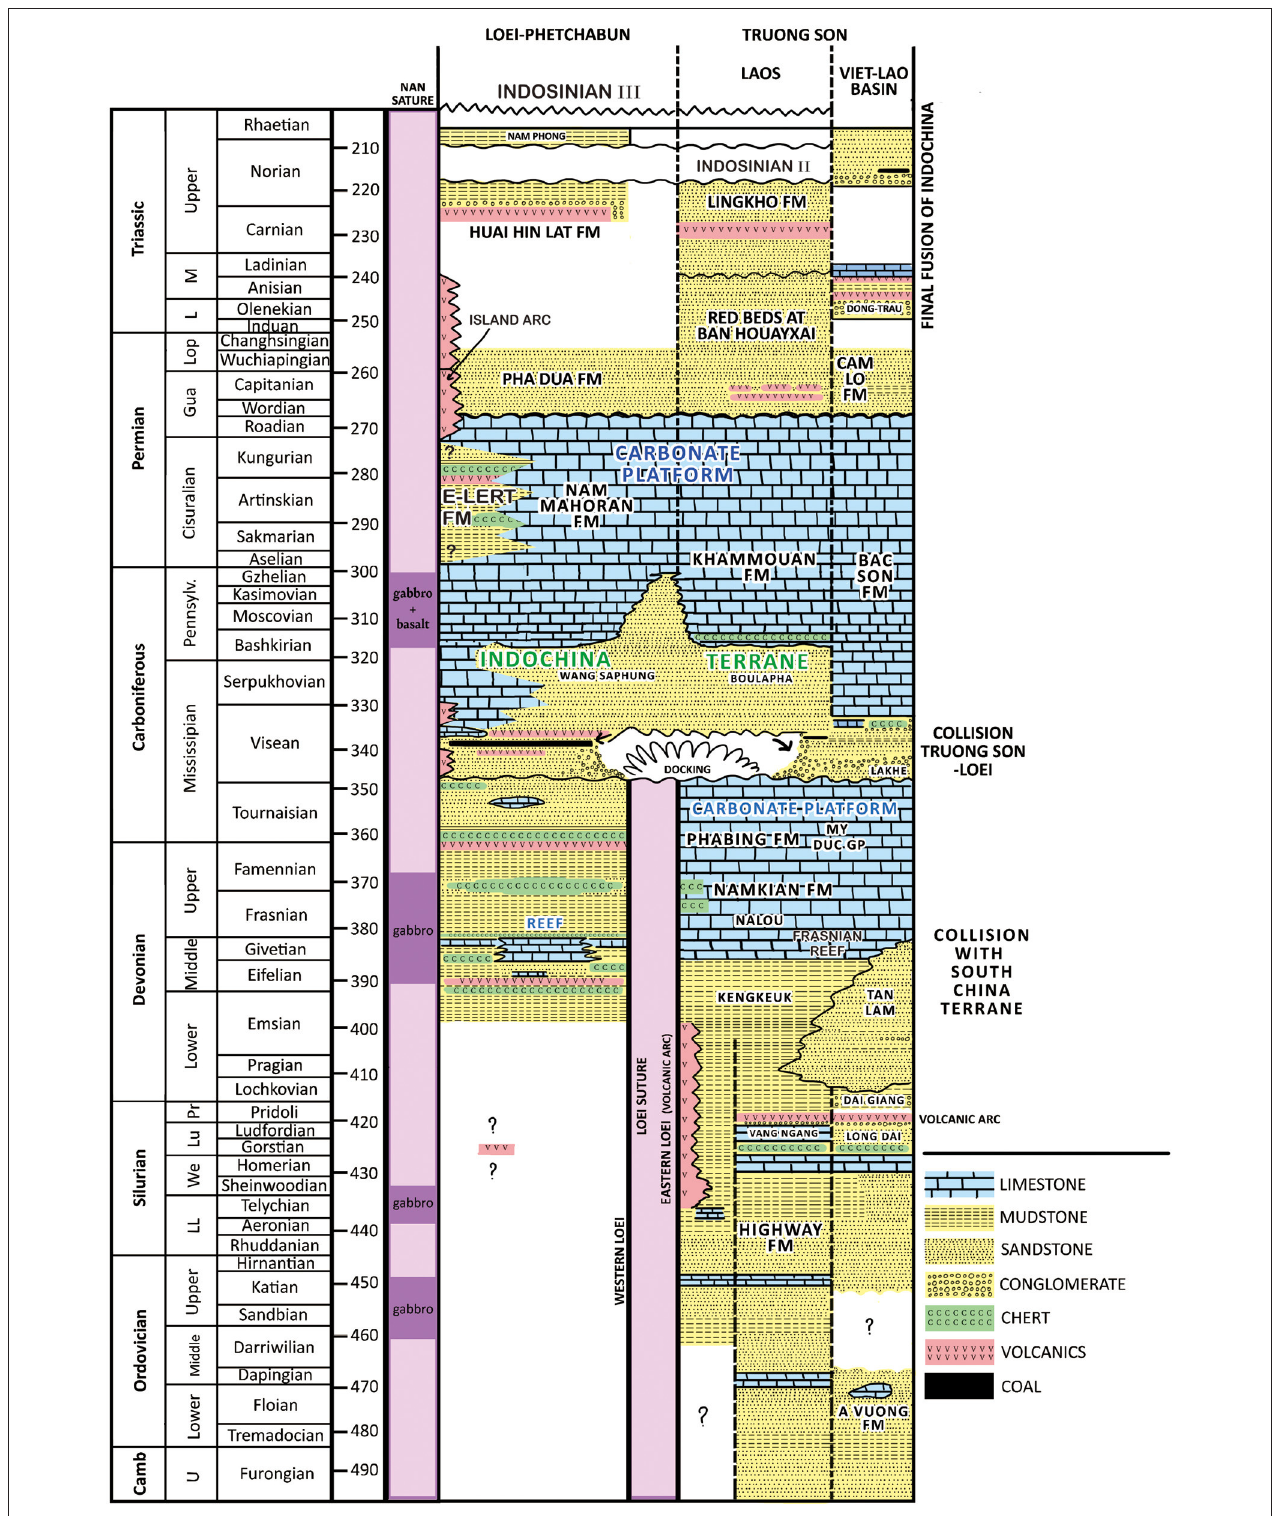
FIGURE 2 | Summary diagram of present hypothesis showing summaries of stratigraphies, deformation episodes, and magmatic events in the Loei-Phetchabun and Truong Son terranes. Stratigraphic data are from numerous sources. Ordovician gabbro within the Nan Suture is from Khin et al. (2014) and Long et al. (2019) and Devonian and Carboniferous dates are from Shen et al. (2010a). The Tan Lam Formation in the Vietnamese sector of Truong Son represents the influx of coarse terrigenous siliciclastics caused by the first collision of the Truong Son Terrane with the South China Terrane in the late Silurian to Early Devonian.